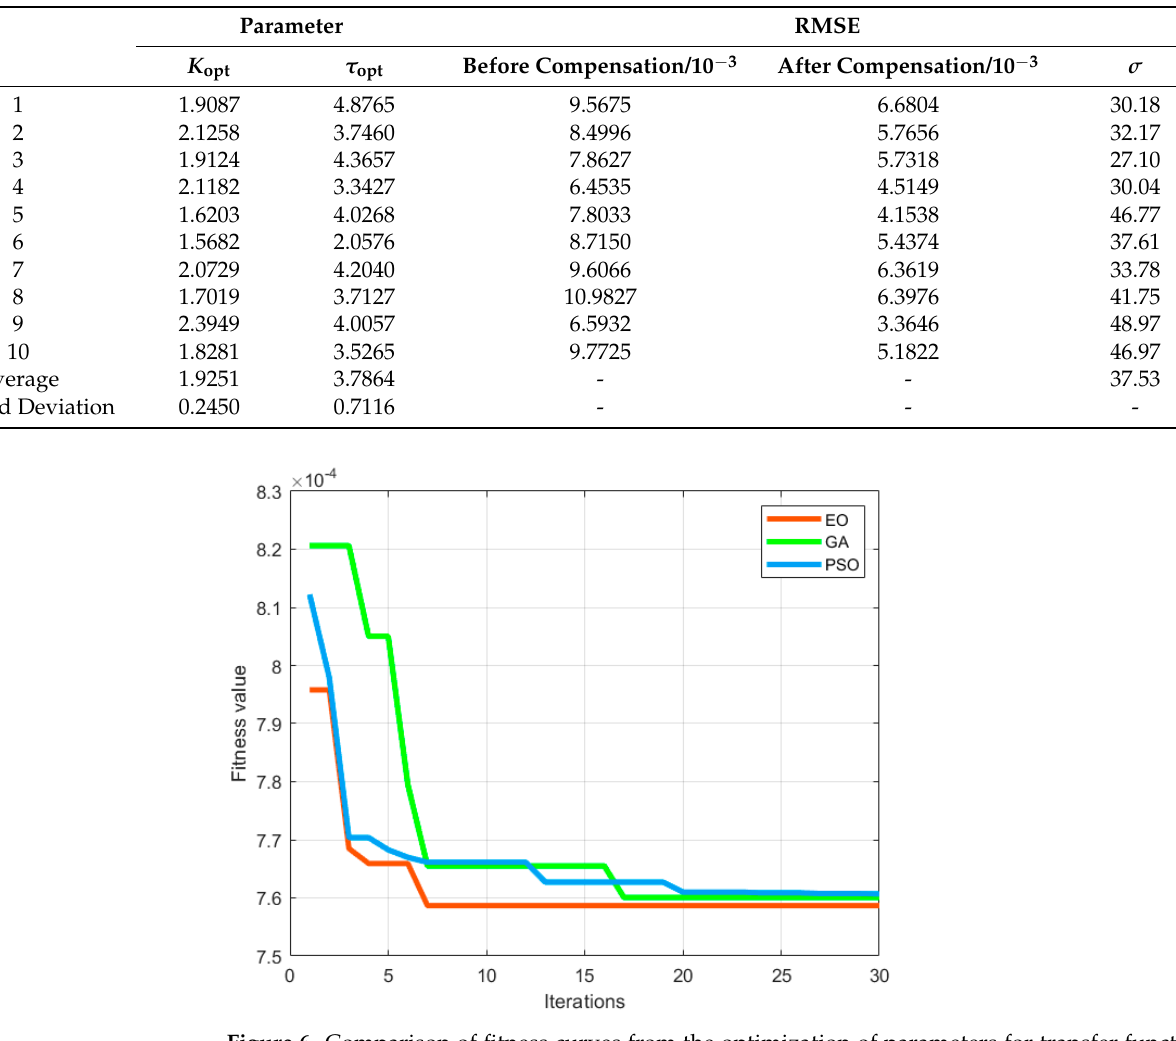
12 of 17 Table 1. Measurement results with ten sets of data. Parameter